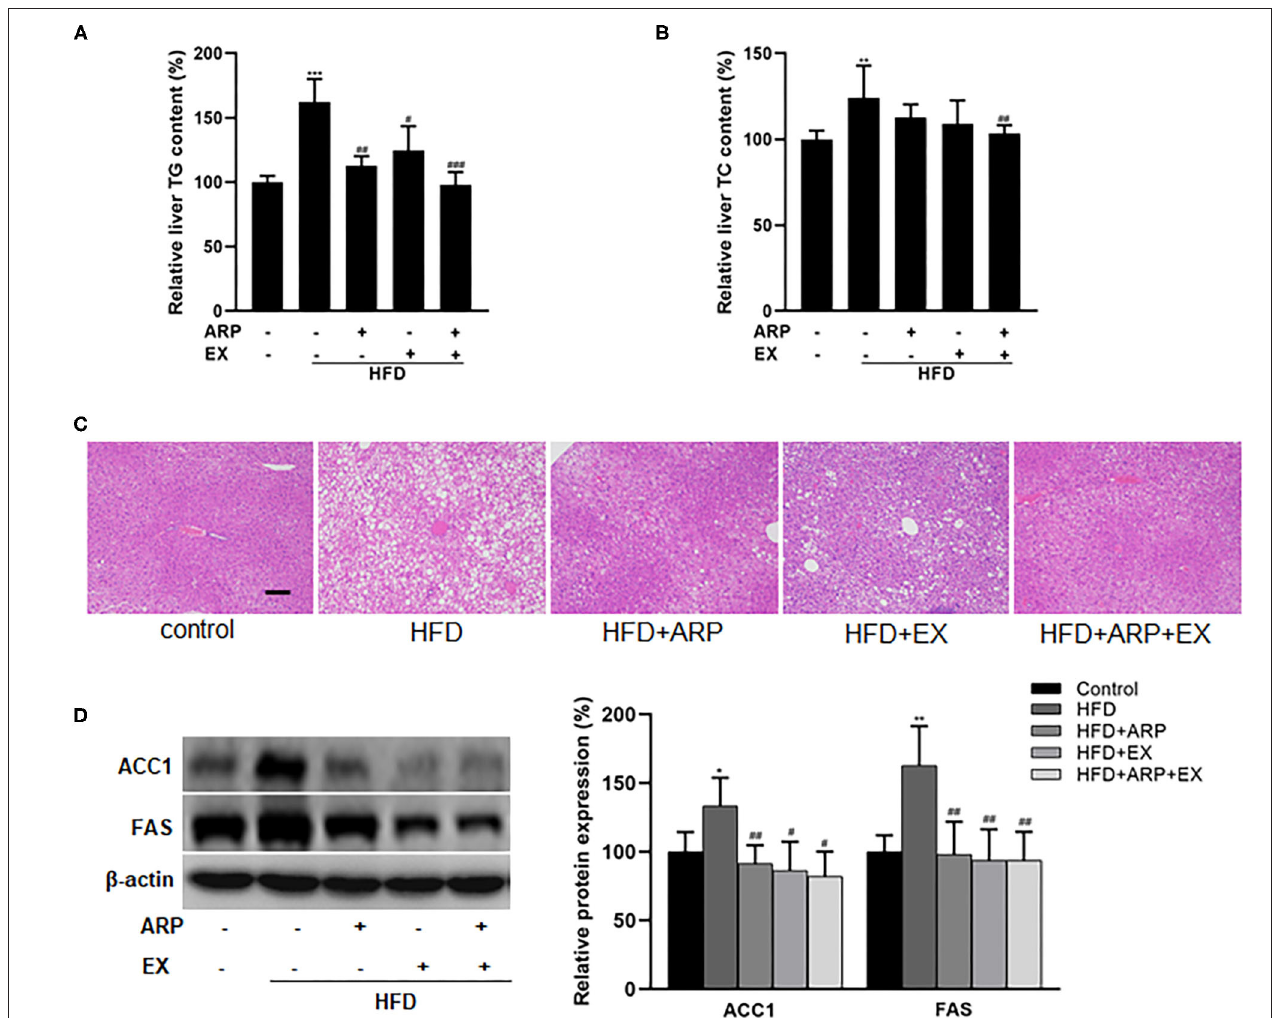
FIGURE 4 | Effects of ARP and EX on lipid accumulation in HFD-fed mice. (A) Liver TG content. (B) Liver TC contents. (C) The histological images of H&E staining in liver tissues. (D) Liver expression of FAS and ACC1 (left, western blot image; right, statistical analysis). TC, total cholesterol; TG, tri-glycerides. H&E staining scale bars: 100 µ m. All the values are exhibited as mean ± SME, n = 8. * p < 0.05, ** p < 0.01, and *** p < 0.001 vs. related control group. # p < 0.05, ## p < 0.01, ### p < 0.001 vs. related HFD